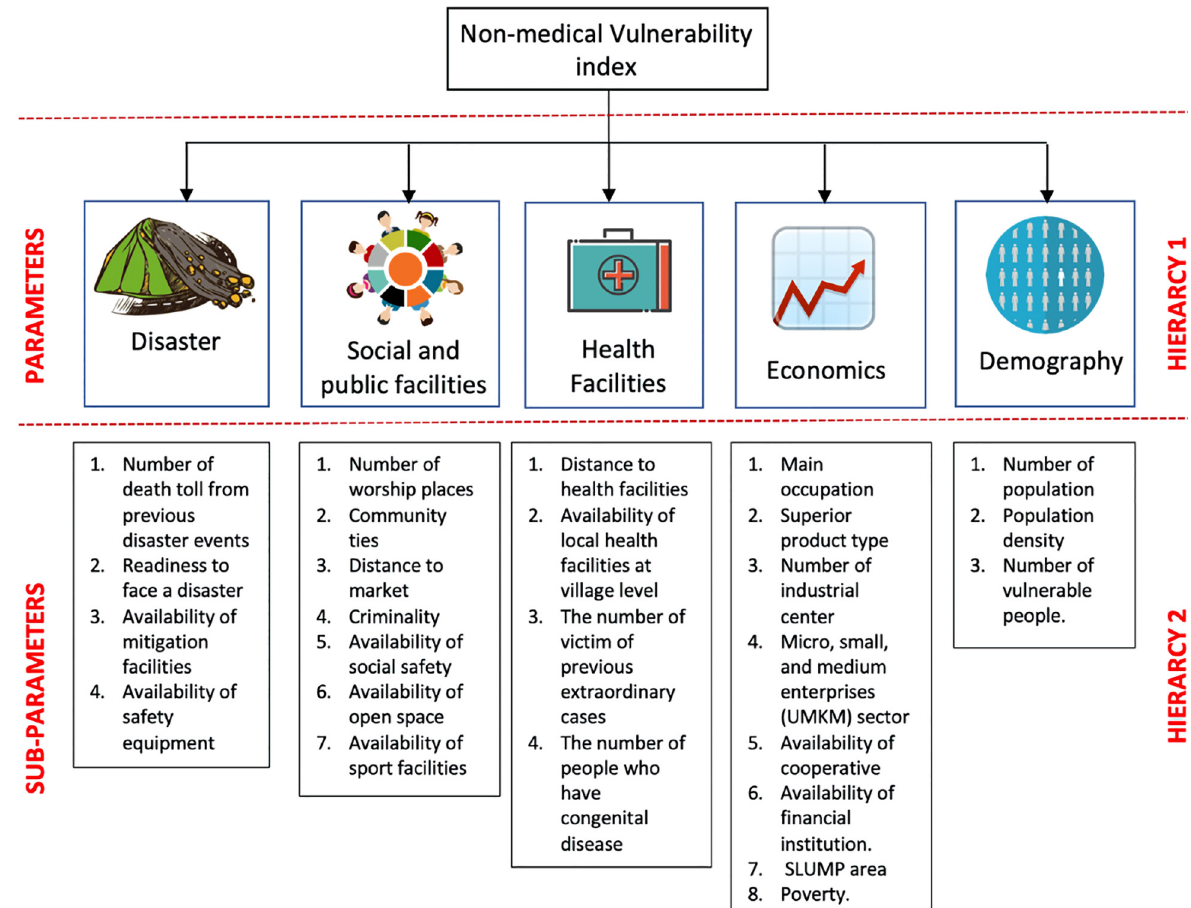
Fig. 5. The list of parameters and sub-parameters used in